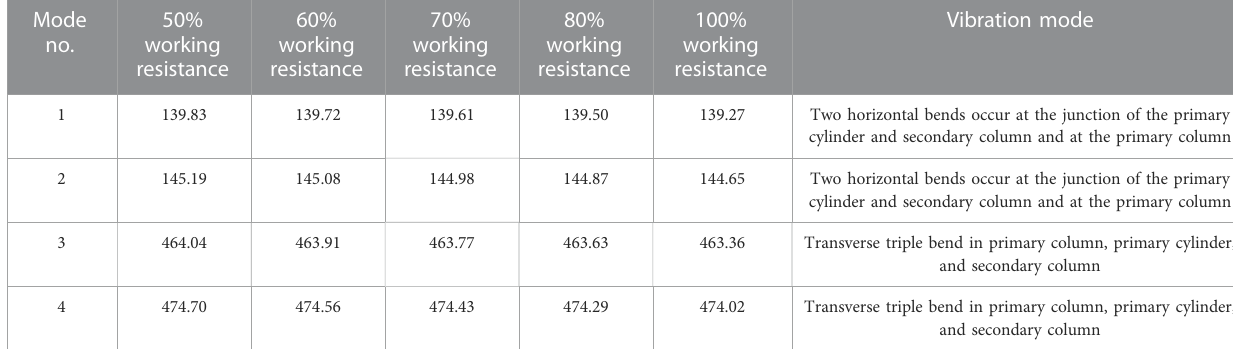
TABLE 8 Vibrational modes and frequencies of the fi rst 4th-order for columns with different setting forces. Mode no.